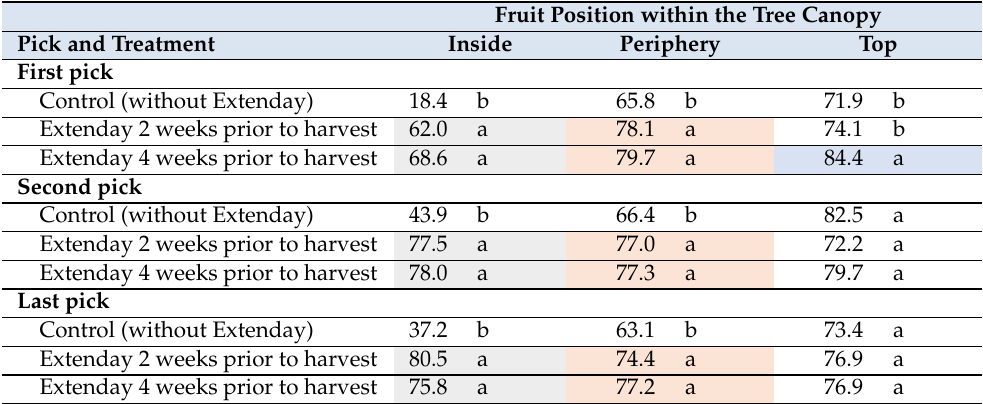
Table 1. Percentage blush of cv. Fuji apple at each pick dependent on fruit position within the canopy. Fruit Position within the Tree Canopy